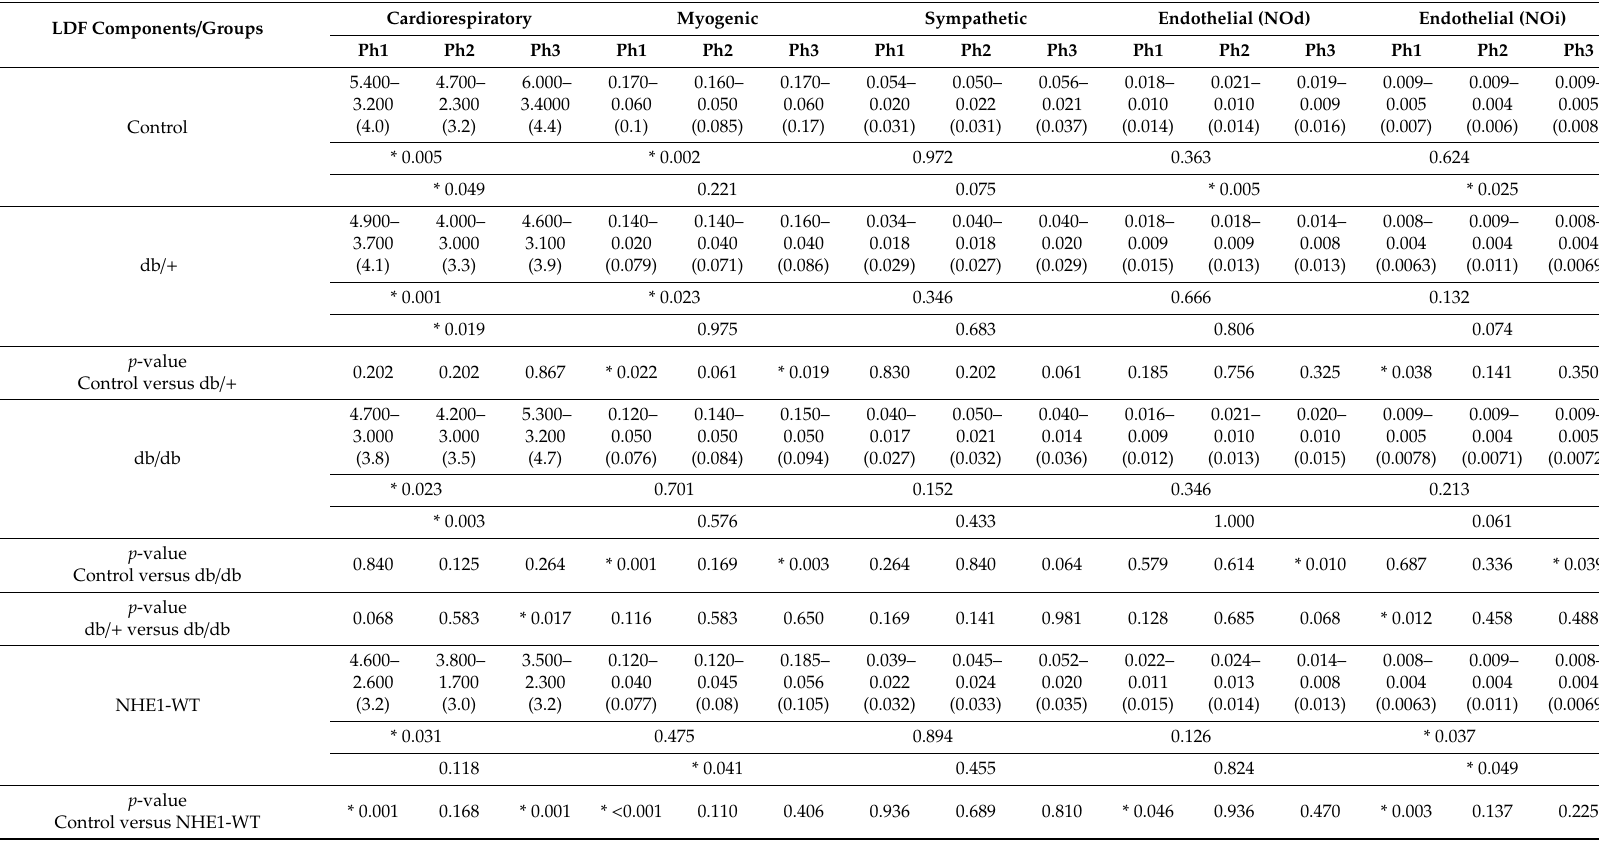
Table 2. Mean frequency ranges and dominant (between brackets) frequencies in Hertz, obtained in all groups of tested animals ( n = 41, animals (8 Controls, 8 db /+ , 8 db / db, 8 NHE1-WT, 9 NHE1-OE) during the di ff erent phases of the experimental protocol (Ph1-baseline; Ph2-hyperoxia; Ph3-recovery). Frequencies are obtained from LDF signals from both hind limbs (means), which allows the identification of each component band (see text). Comparative statistics are shown, for each component’s dominant frequency in each group, regarding baseline recording (* statistically significant di ff erence p <